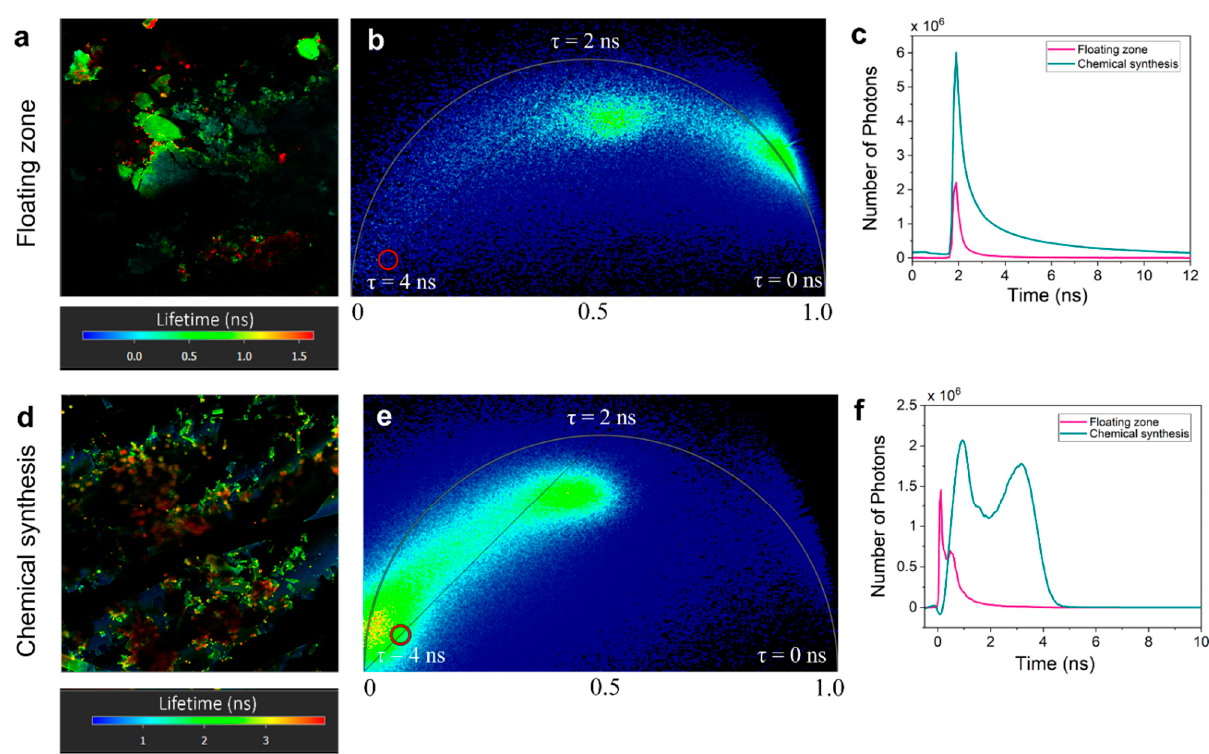
Figure 7. Comparison of FLIM results for CsPbBr 3 obtained through the floating zone and chemical synthesis method; ( a ) lifetime image and ( b ) phasor plot for floating zone method; ( c ) lifetime fitting comparing floating zone and chemical synthesis method; ( d ) lifetime image and ( e ) phasor plot for chemical synthesis method; ( f ) photon distribution with lifetime comparing the floating zone and chemical synthesis method.